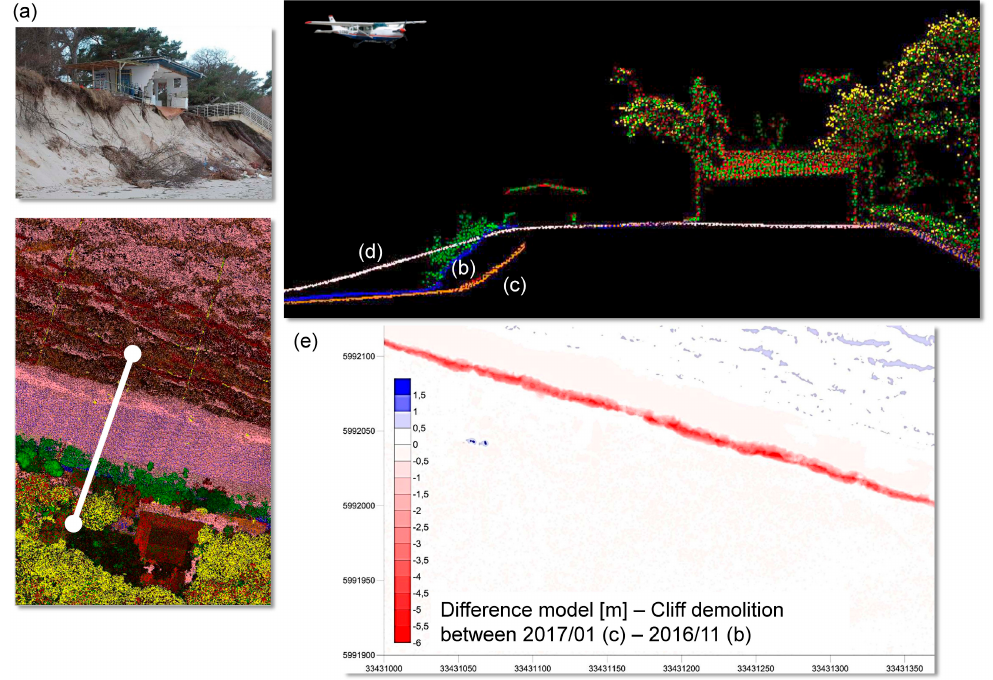
Figure 11. ( a ) Cliff demolition of an area of the outer coast, Zemplin Fule (Germany): ( a ) Photo of the cliff depicted in 3 D profile view of a Digital Terrain Model (DTM) and a Digital Surface Model (DSM) that were created by Airborne Laser Scanning (ALS) in ( b ) 11/2016, ( c ) 1/2017, and ( d ) 7/2019. ( e ) Difference model [m] of the cliff demolition between 1917 and 1916.